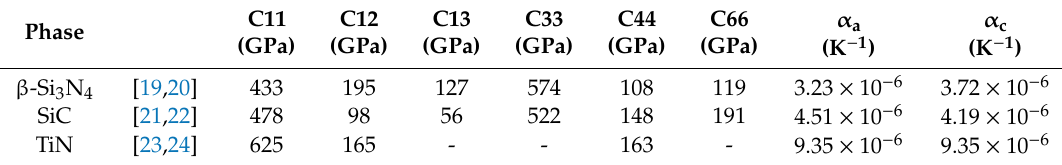
Table 2. Elastic constant C ij and thermal expansion coe ffi cients.